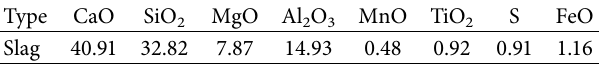
Table 1: Chemical composition of slag